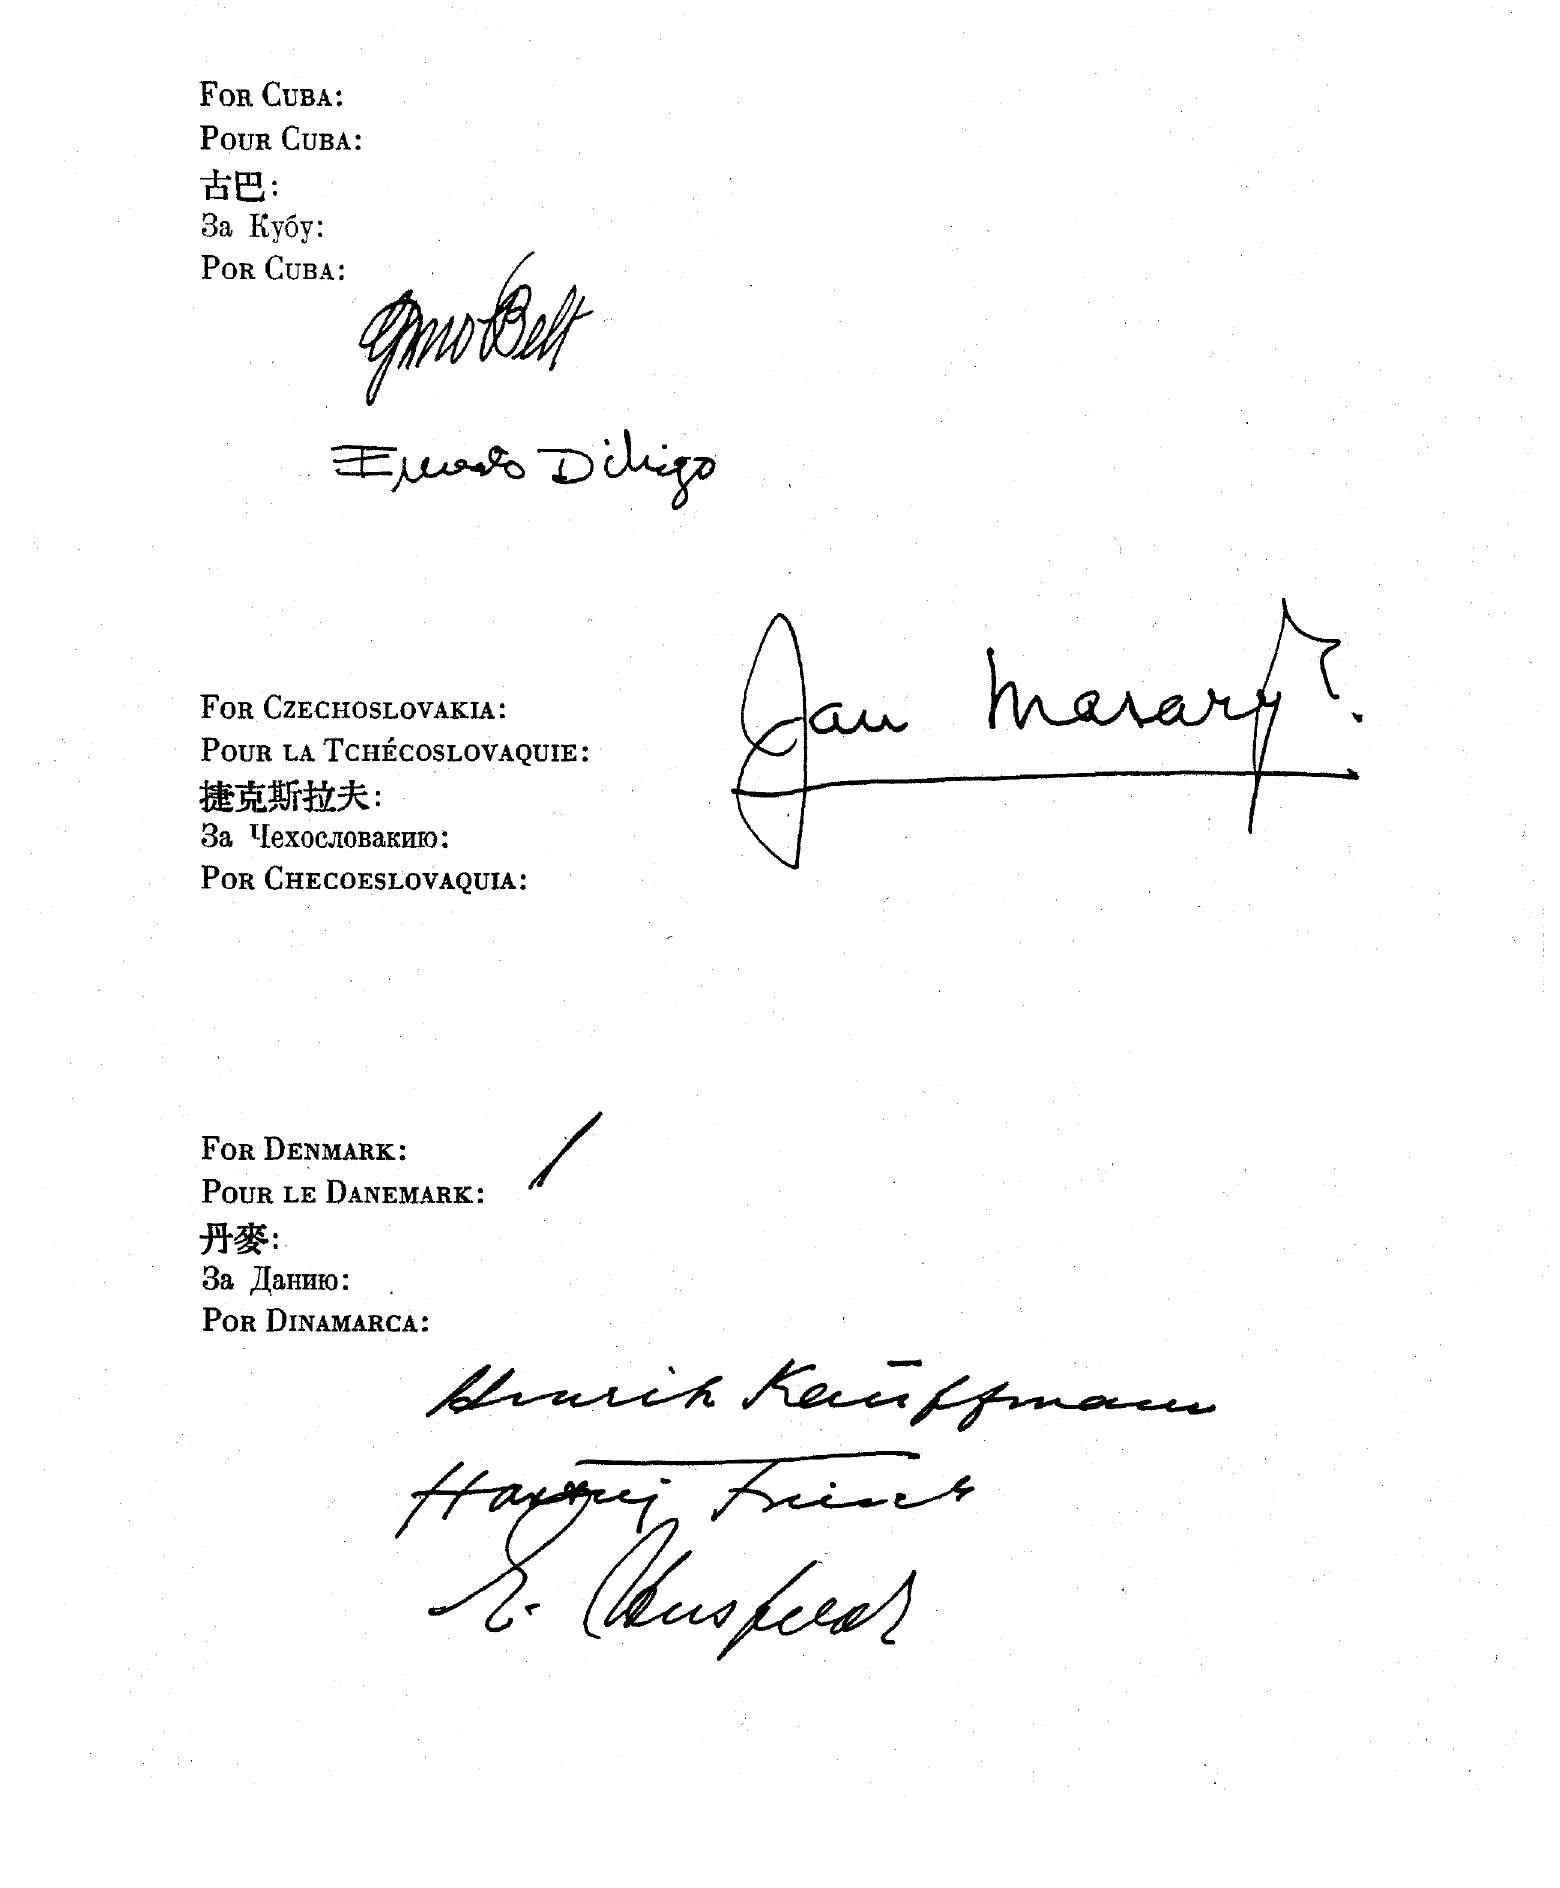
FOR CUBA: POUR CUBA